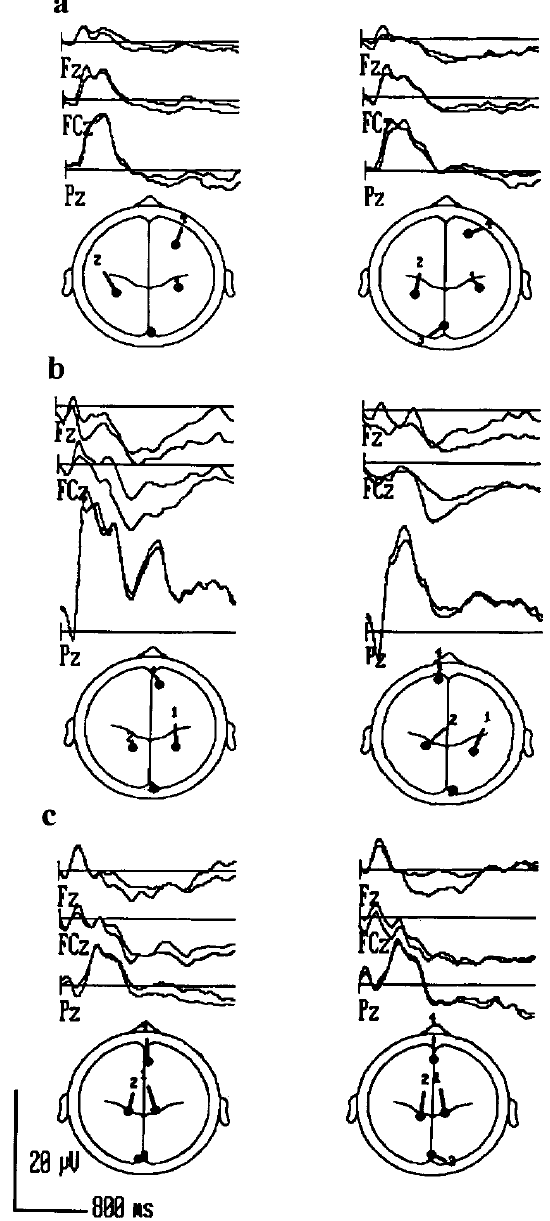
Fig. 3. CNVs associated with the visual pattern and place recog- nition tasks in three other subjects. The example waveforms and corresponding model waveforms are superimposed and the 4-dipole models are shown in a view from the top. On the left are the pattern recognition CNVs and models and on the right are the place recog- nition CNVs and models; a , b and c indicate individual subjects.